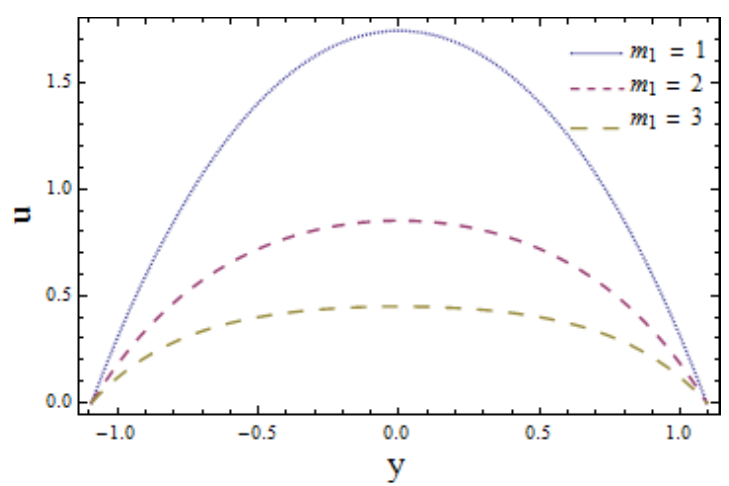
Figure 6. Velocity u versus y with m 1 when (cid:101) = 0.1, x = 0.2, t = 0.01, E 1 = 0.4, E 2 = 0.2, E 3 = 0.3, m = 0.04, n = 0.4 and We = 0.03.